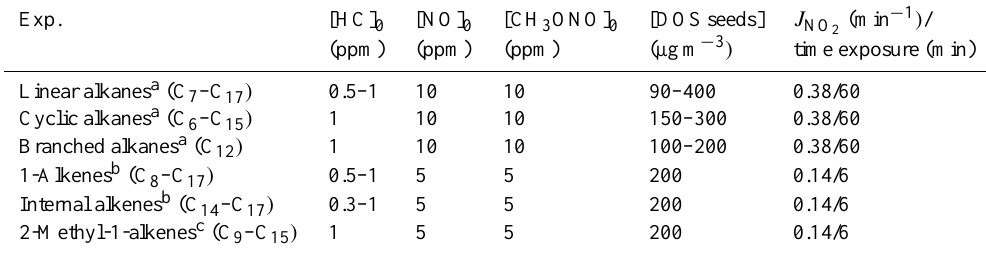
Table 1. Measured injected concentrations and environmental conditions of the experiments. Exp.